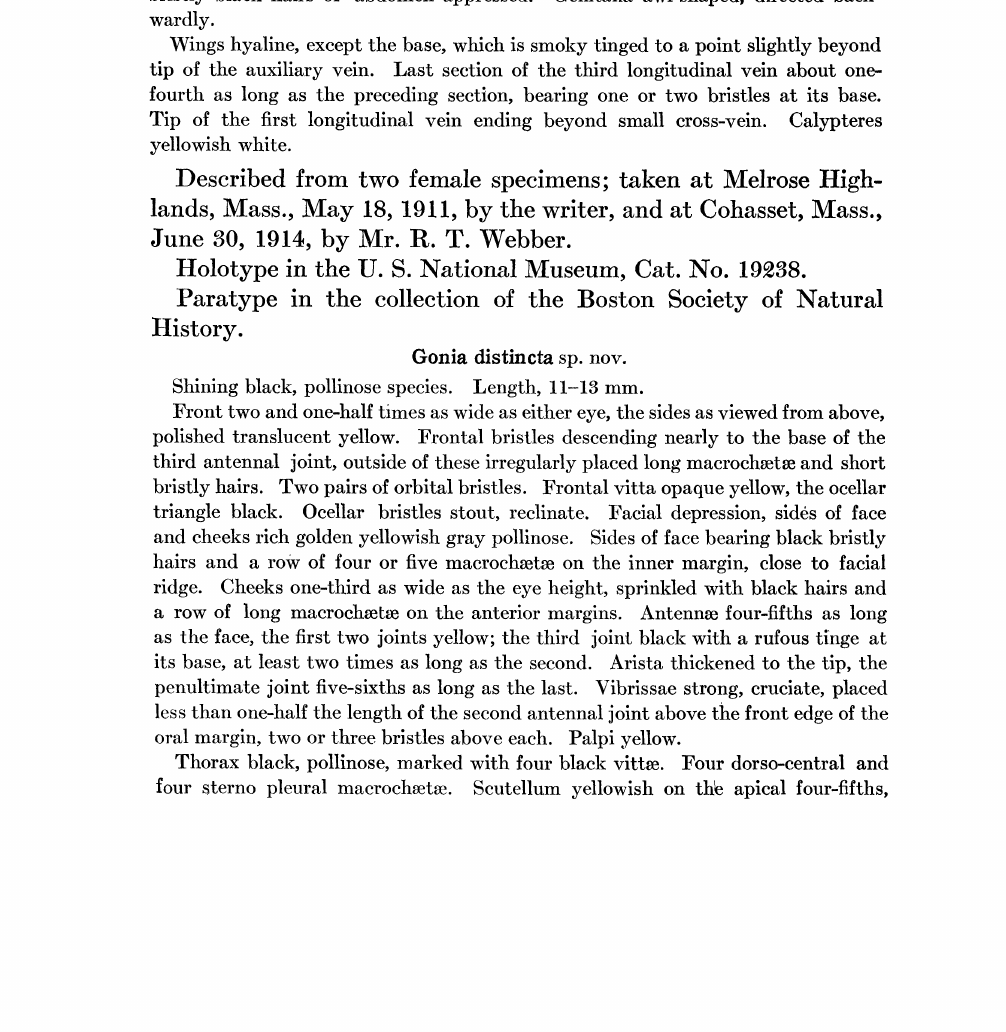
of face yellowish gray pollinose, a spot near the middle bordering the margin of facial plate, piceous. Cheeks one-third as wide as the eye height, bearing numer- ous long white hairs. 1)alpi yellow. Thorax marked with four black virtue, the two median virtue fading out just posterior of the transverse suture. Dorso-central bristles, two, the anterior bristles short and weak. Sterno-pleura bearing one long bristle and numerous black hairs. Scutellum black, pollinose, bearing two pairs of marginal bristles. Legs yellowish, pollinose, tarsi black. Middle tibim each bearing a single short bristle, placed below the middle; the hind tibim pectinate with several bristles on the outer side. Abdomen short, flattened, and nearly round. Shining black, segments two and three brassy pollinose on the basal two-thirds, the fourth segment wholly brassy pollinose. A median black dorsal vitta on the first three segments. Numerous bristly black hairs of abdomen appressed. Genitalia awl-shaped, directed back- wardly. Wings hyaline, except the base, which is smoky tinged to a point slightly beyond tip of the auxiliary vein. Last section of the third longitudinal vein about one- fourth as long as the preceding section, bearing one or two bristles at its base. Tip of the first longitudinal vein ending beyond small cross-vein. Calypteres yellowish